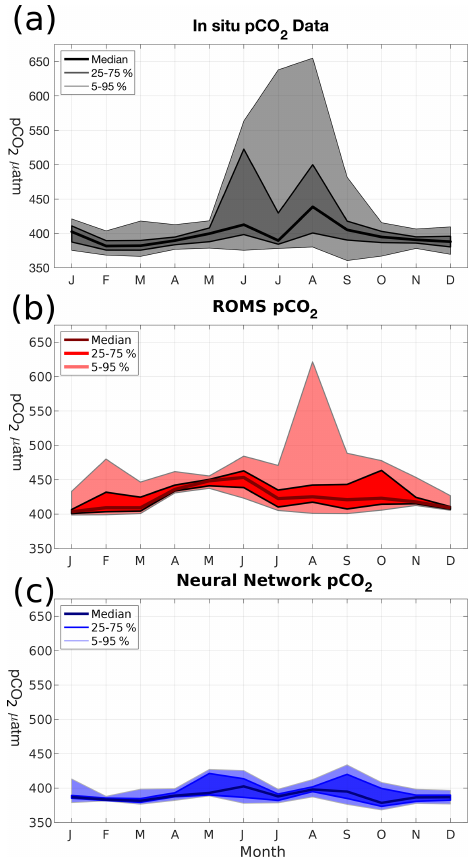
Figure 5. Monthly probability density distributions of surface p CO 2 (µatm) in (a) merged SOCAT–LDEO in situ data, (b) modeled p CO 2 , and (c) L15 p CO 2 climatology.